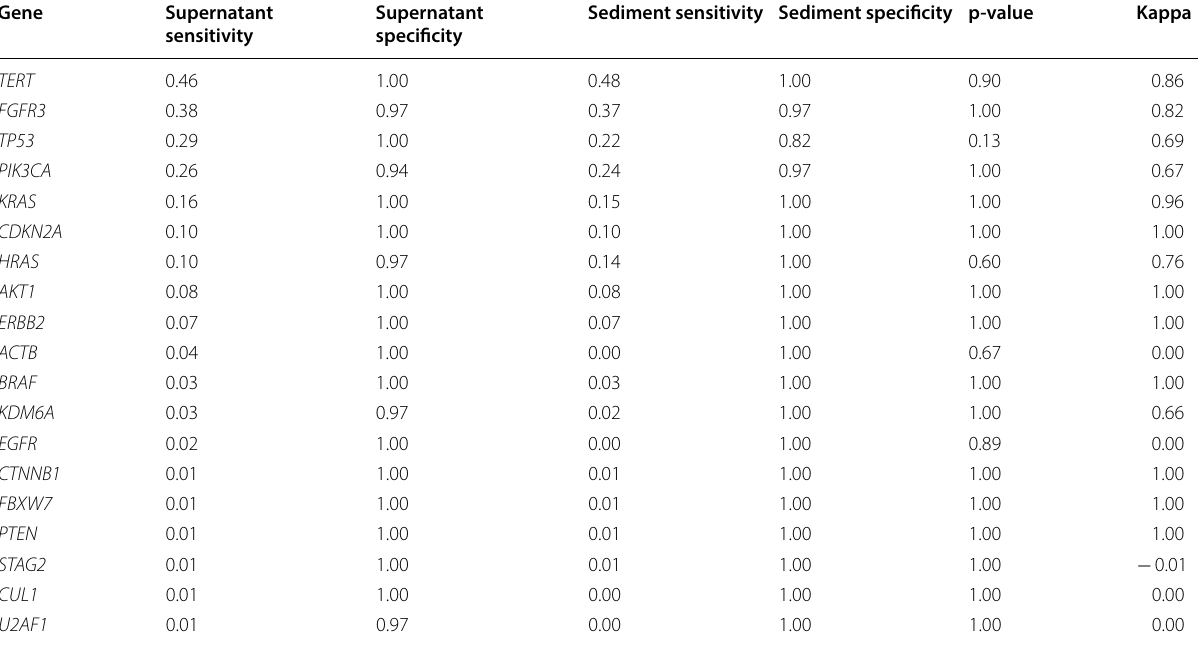
Table 3 The kappa values of each gene among the 125 supernatant and sediment samples Gene Supernatant Supernatant sensitivity